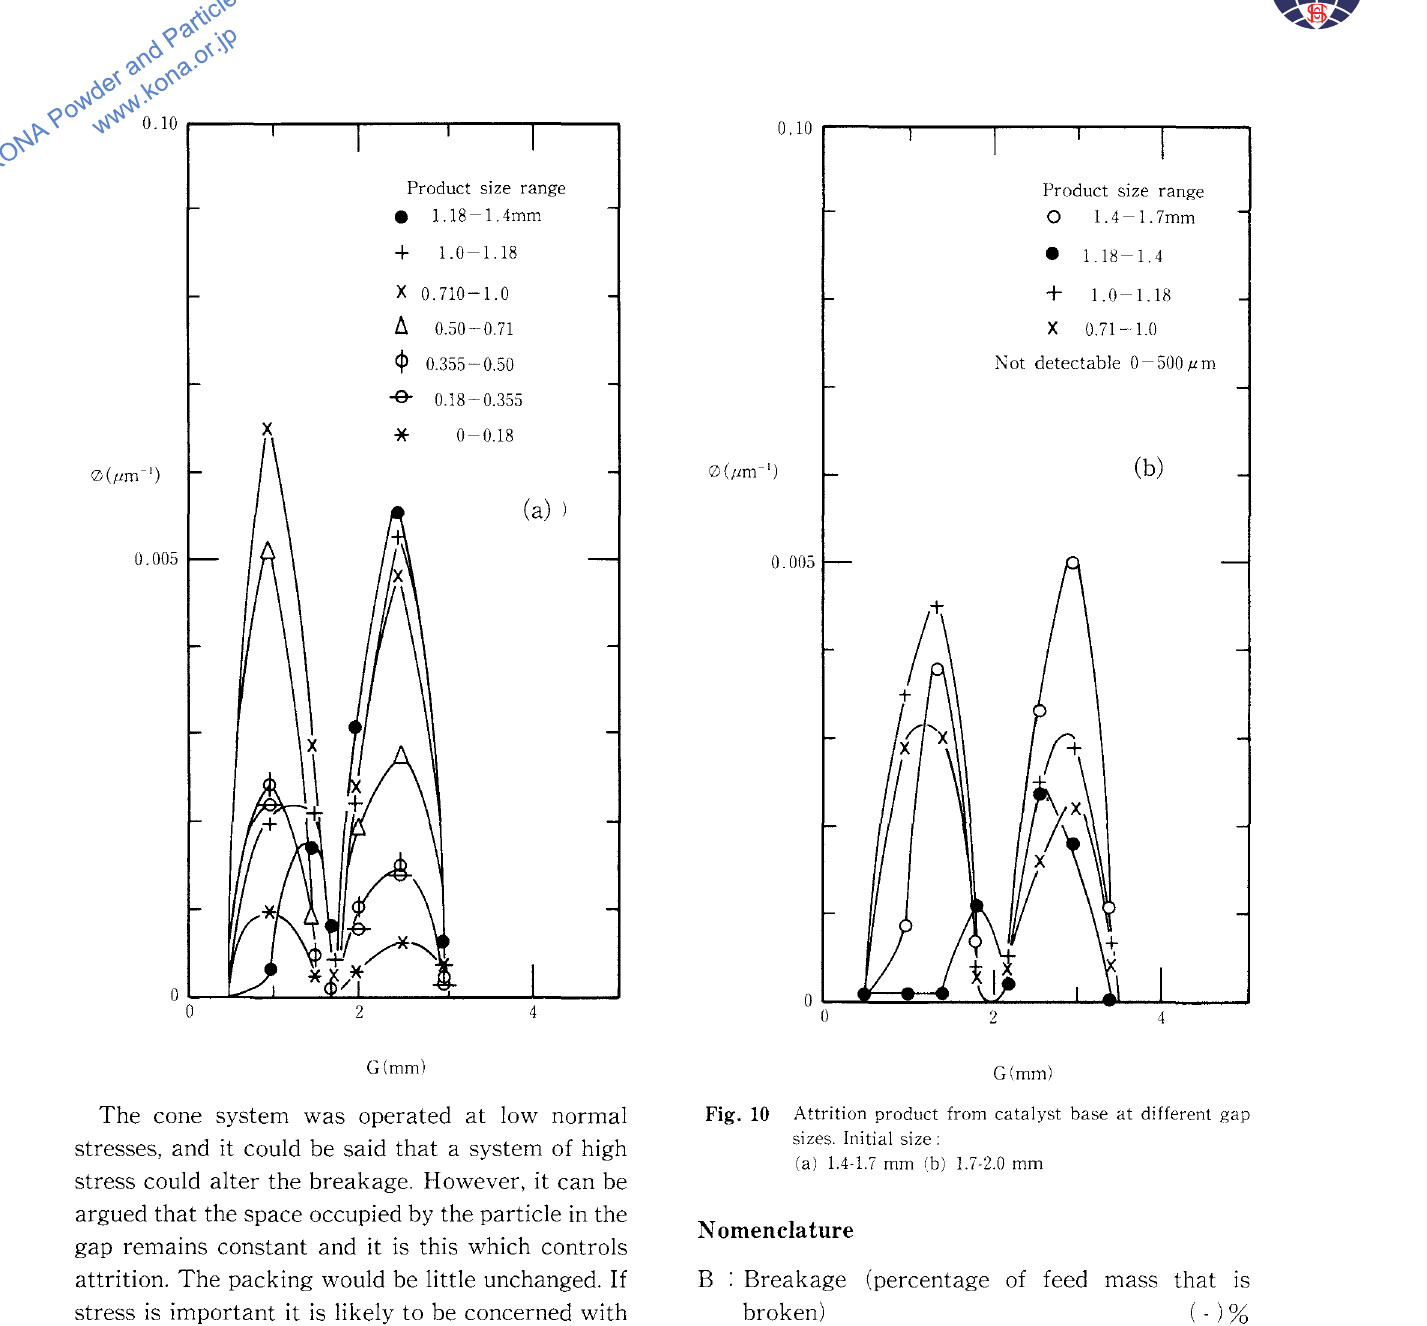
Fig. 10 Attrition product from catalyst base at different gap sizes. Initial size: (a) 1.4-1.7 mm !b) 1.7-2.0